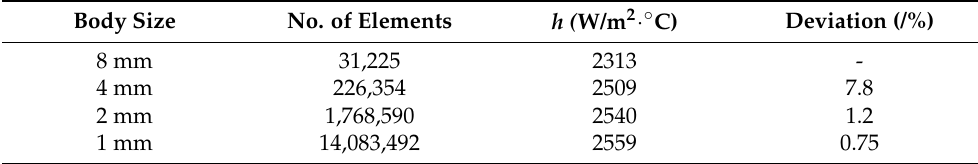
Table 5. Grid independent study. Body